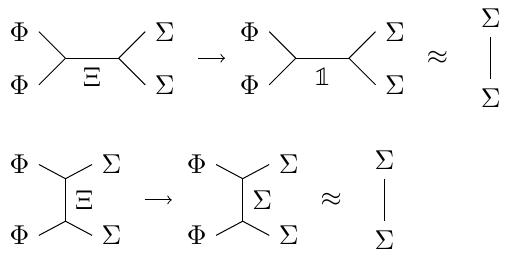
Figure 3 . The leading contribution to the anomalous dimension of h Σ comes from the conformal block where ΦΦ fuse together into Ξ = 1 (upper part) or ΦΣ fuse together into Ξ = Σ (lower part). Due to the conformal weight of Φ being of order N 0 , these blocks are approximately equal to the two-point function h ΣΣ i in the large N